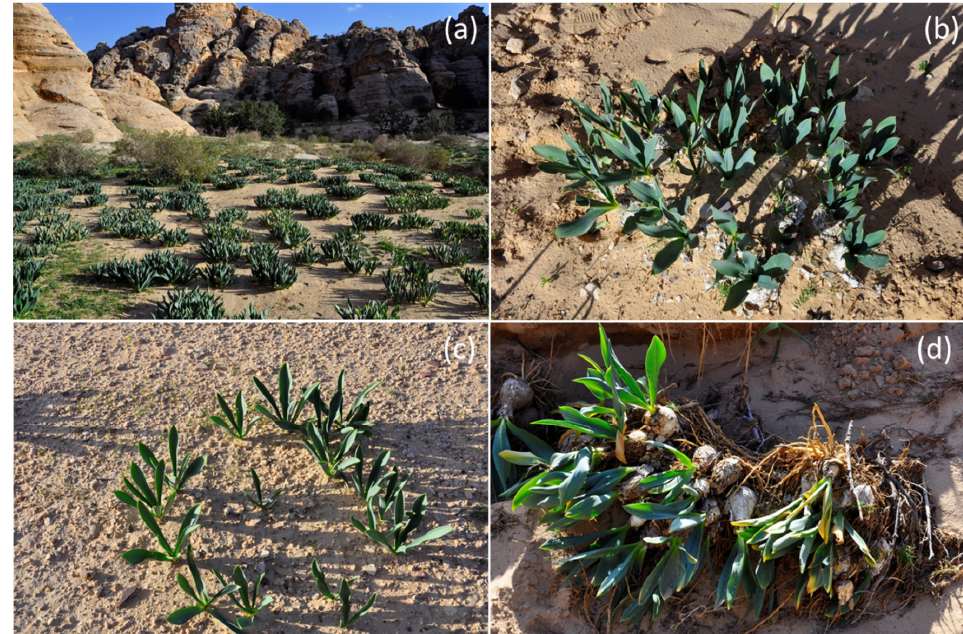
Figure 3. ( a ) A view of the study site, ca. 0.5 km south of Little Petra, southern Jordan. Two rings of U. maritima are shown in panels ( b , c ). Note that the plant in the middle of the ring in panel ( c ) is smaller than the plants in the ring’s periphery, probably due to the intense competition over soil water with the plants in the periphery. ( d ) Bulbs of an U. maritima ring that were uprooted by a flooding stream. Note the long lateral roots that extend from the bulbs.